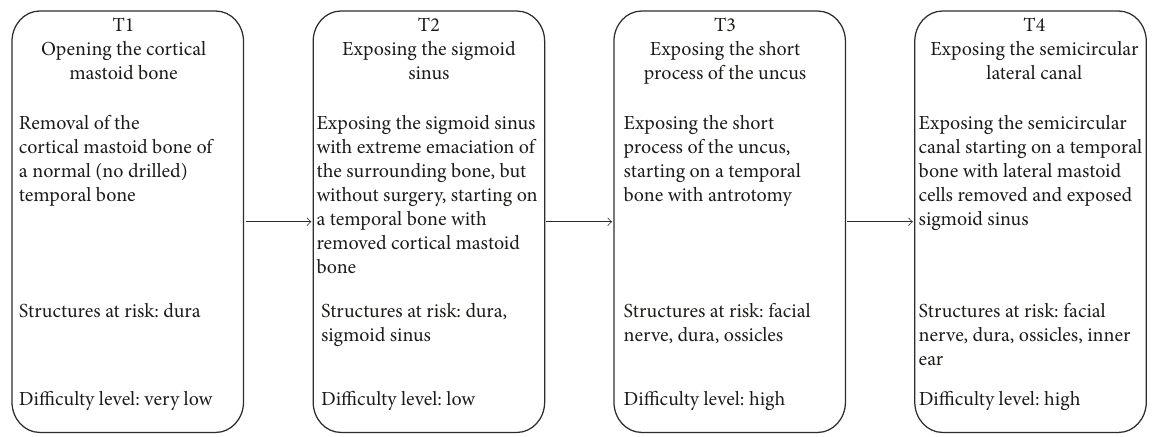
Figure 2: Illustration of the experimental